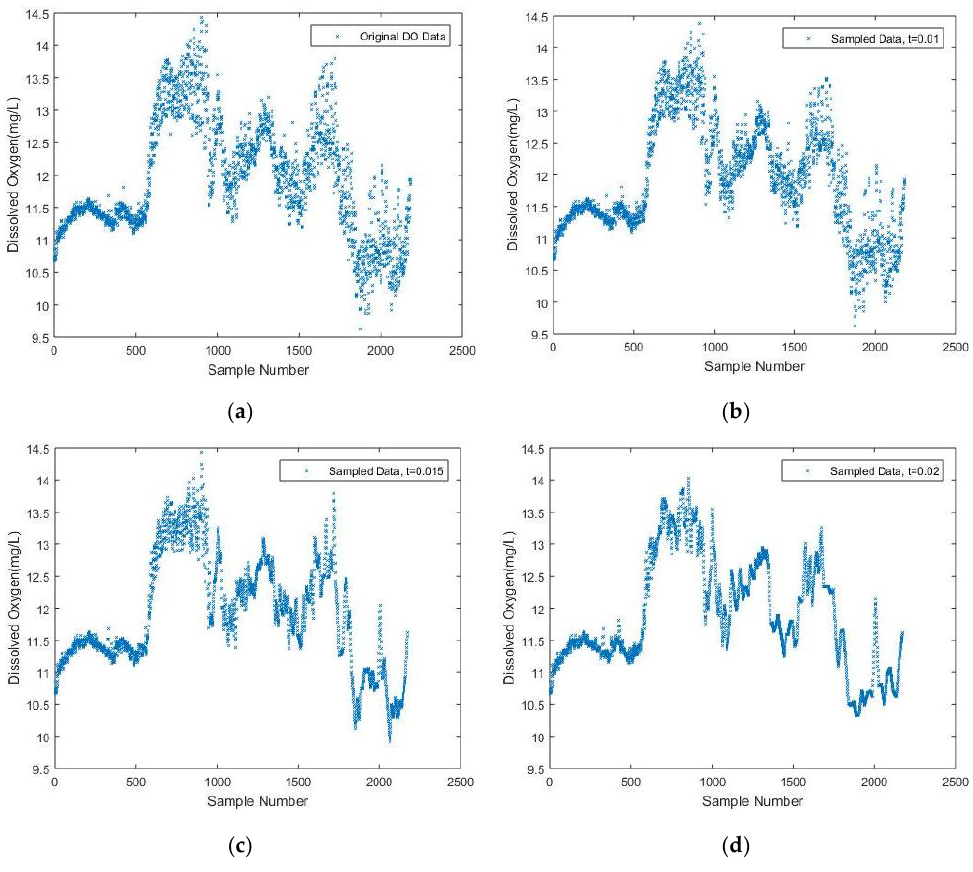
Figure 2. ( a ) Original dissolved oxygen (DO) Data; ( b ) Sampled DO data with t = 0.01; ( c ) Sampled DO data with t = 0.015; ( d ) Sampled DO data with t = 0.02.